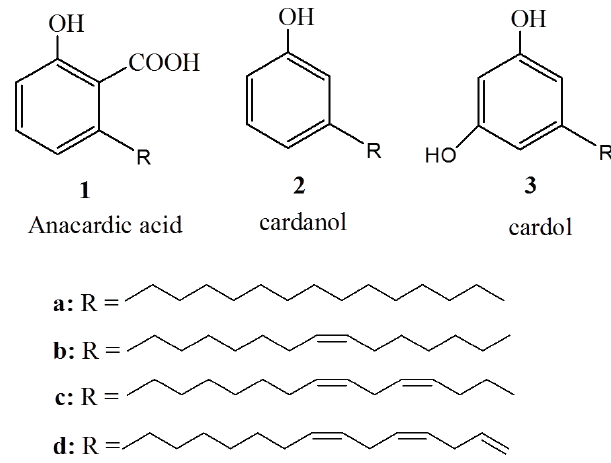
Figure 1. The major components of cashew nut shell